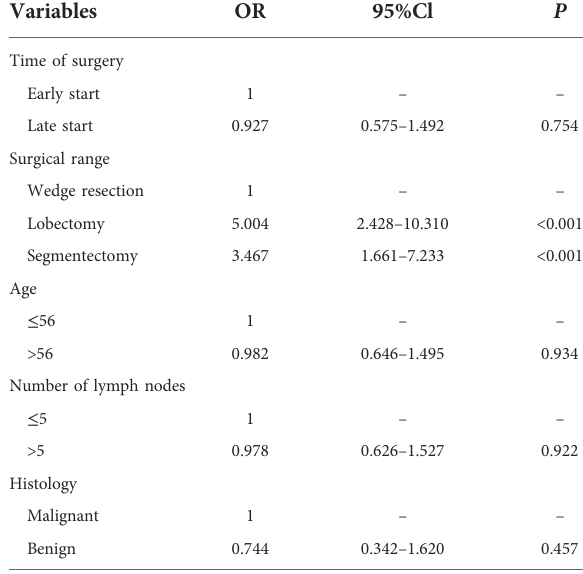
TABLE 5 Multivariable logistic regression analysis of operation